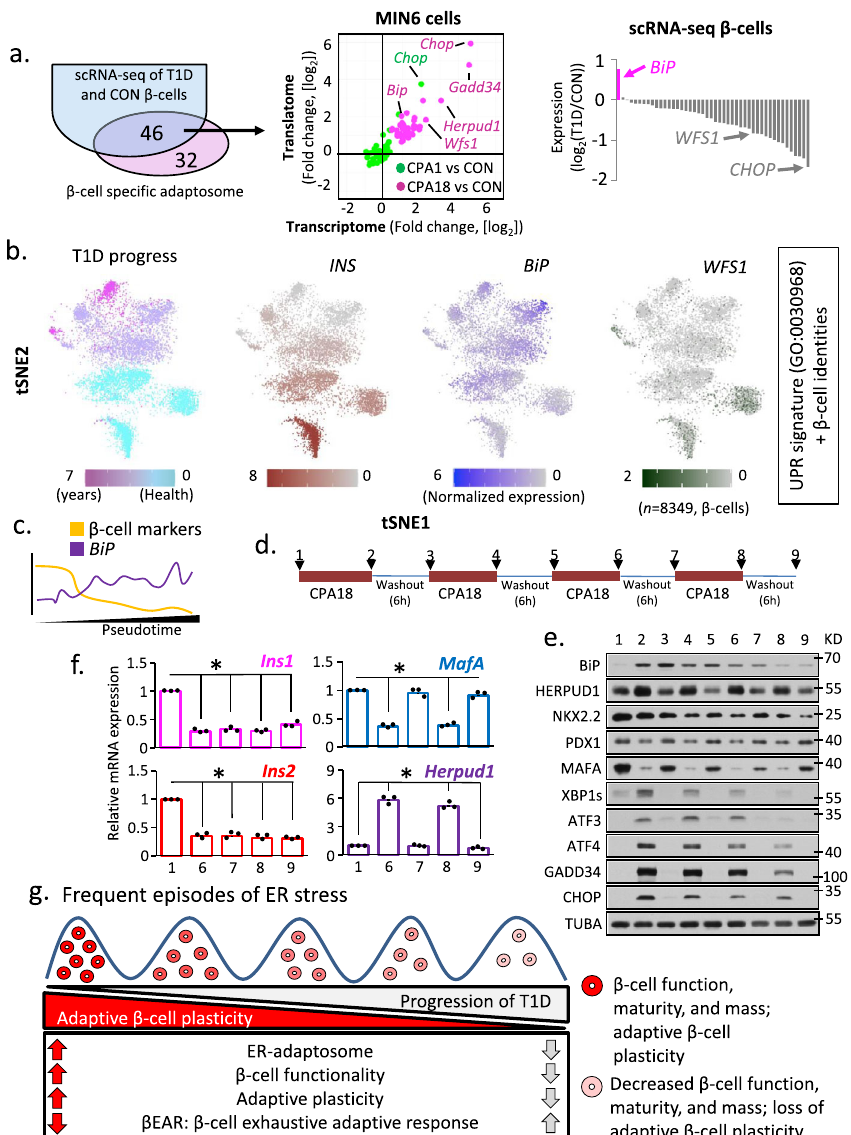
Fig. 7 | Progression of T1D pathogenesis correlates with ER-stress-induced adaptive exhaustion and suppression of β -cell maturity markers. a Schematic representationofthecommongenesbetweenthe β -cellspeci fi cadaptomeinMIN6 cells(78genes)andthe β -cellsscRNA-seqdatasets.Plotsshowtheregulationofthe 46 genes in MIN6 cells during acute and chronic ER stress (middle) and β -cells scRNA-seq from healthy and T1D patients (right). b Relevant distance in gene expressionbetweentwodatasets:(tSNE1)scRNA-seqdatasetfromallhuman β -cells (healthyandT1D,8349)and(tSNE2)theexpressionofagroupofgenesconsistingof both, the UPR signature genes (GO:0030968), and 6 β -cell-speci fi c gene markers (INS, PAX6, NKX2.2, NKX6.1, MAFA and PDX1). Colored from left to right, T1D progression, INS , BiP and WFS1 . Darker color indicates higher expression of the